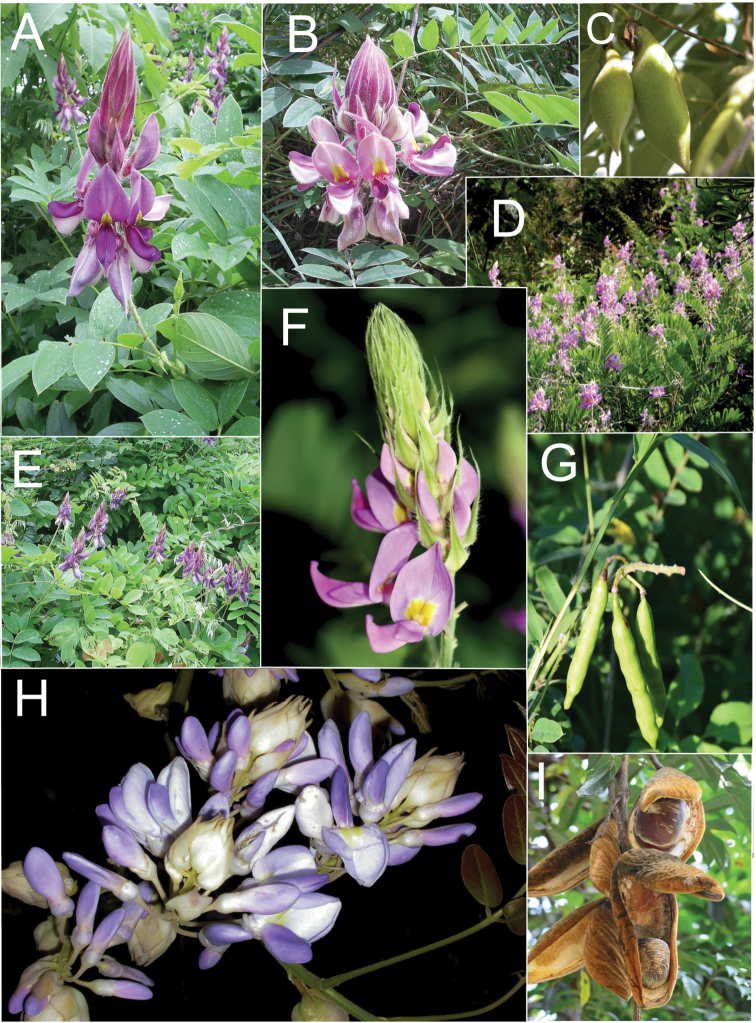
Afgekia, Sarcodum and Padbruggea. AAfgekiamahidoliae, Thailand, Sai Yok distr. Kanchanaburi, Y.Sirichamorn s.n.. B, CAfgekiasericea Thailand S.Mattapha 1158DSarcodumscandens Vietnam, Quang Binh Prov. Lôc & Quang P11554EAfgekiamahidiliae Thailand, Sai Yok distr. Kanchanaburi Y.Sirichamorn s.n.. FSarcodumscandens Vietnam, Quang Binh Prov. Lôc & Quang P11554GSarcodumscandens Laos, Sop Teuang, Bolikhamxai Prov. S.Lanorsavanh 1299H, IPadbruggeafilipes Thailand, Chiang Mai, Y.Sirichamorn & S.Mattapha YSM2017-1.